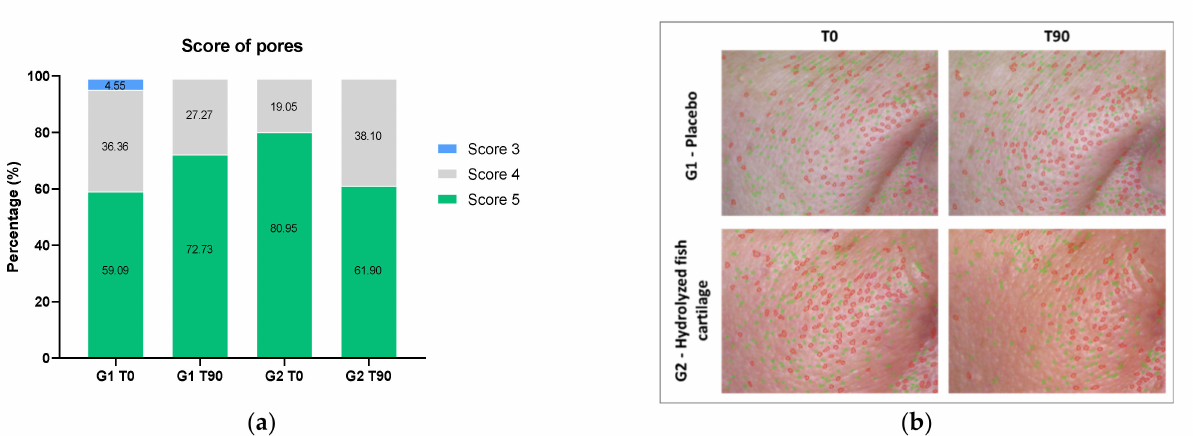
Figure 5. ( a ) Pore score (%) for the malar region of the face of the participants before (T0) and after 90 days (T90) of supplementation with the placebo or hydrolyzed fish cartilage. The results are reported as relative frequency of scores. ( b ) Representative 3D high-resolution images of pores in the malar region of the face before (T0) and after 90 days (T90) of supplementation with hydrolyzed fish cartilage or the placebo. Triplicate images of each participant were analyzed using the Visioface ® Quick software version 1.0.3.4.